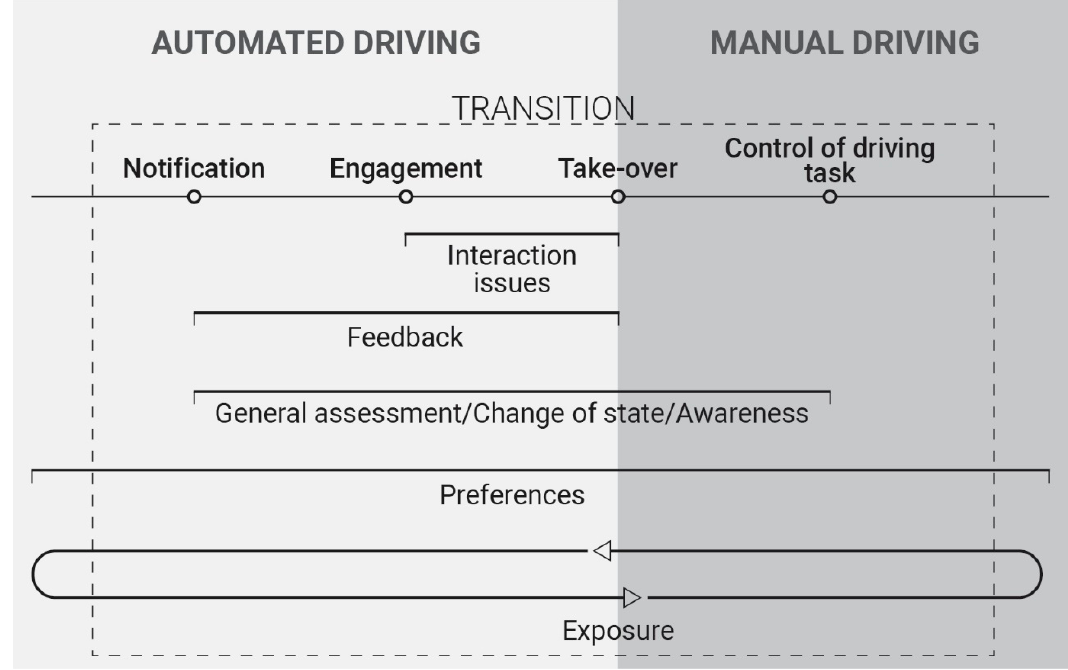
Figure 5. Temporal differences between underlying reasons affecting the user experience in the transition from automated driving to manual driving. The dashed square represents the transition procedure and the circles represent the different events involved.